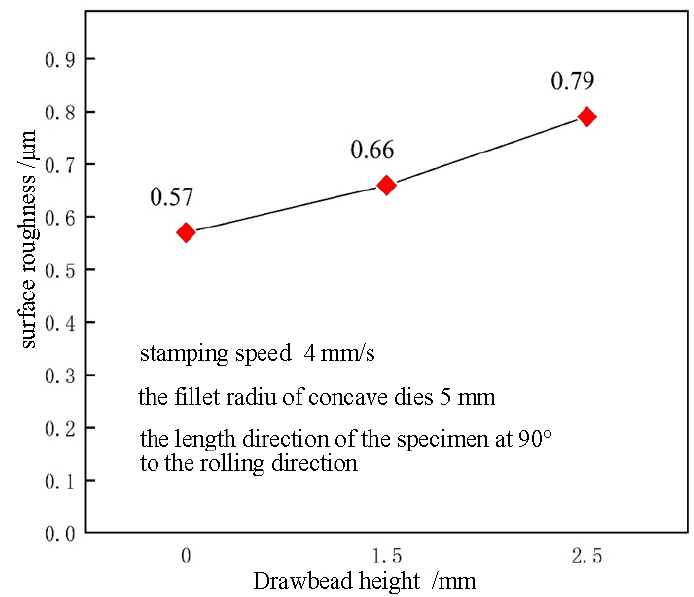
Figure 10. Surface roughness of specimen with different height of drawbead.